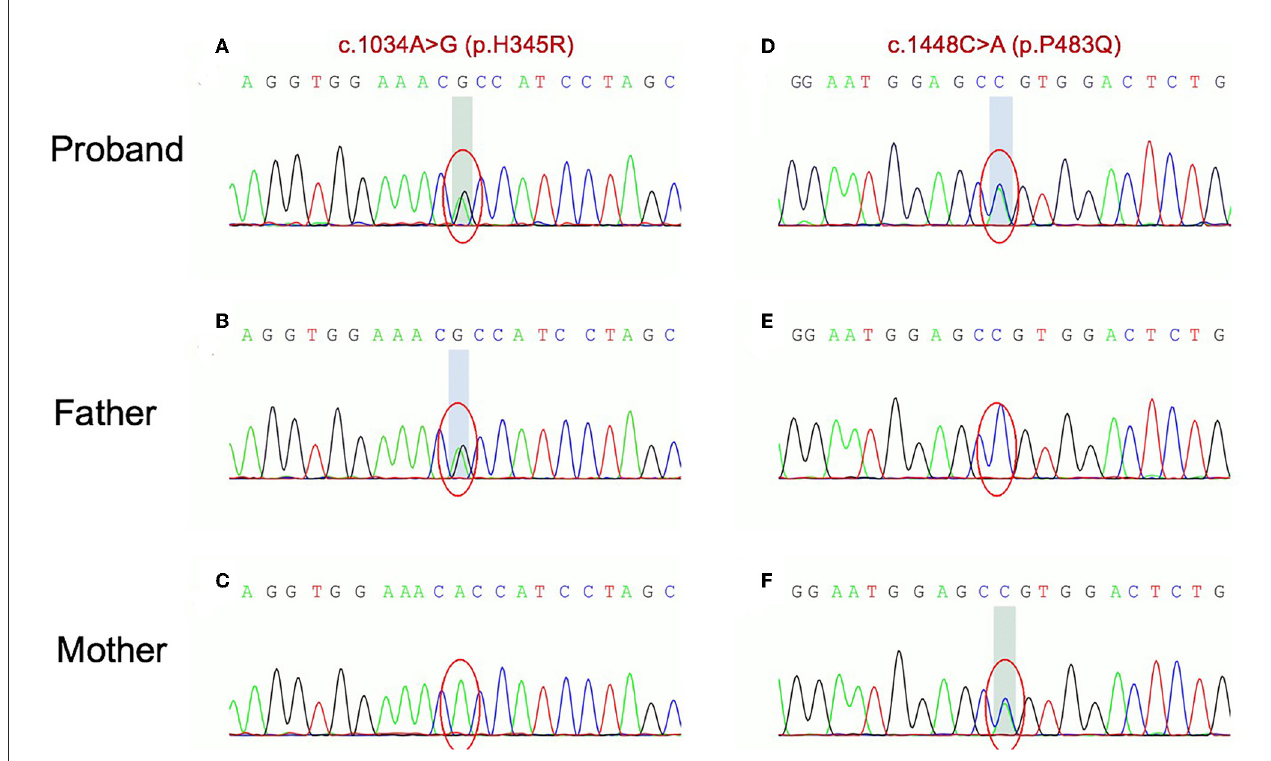
FIGURE3 Sanger traces for PCR products of the proband and his parents. Sanger traces for PCR products of the proband indicated a compound heterozygous mutation in ETFDH gene: c.1034A > G (p.H345R) on exon 9 (A) and c.1448C > A (p.P483Q) on exon 11 (B) . Sanger traces for PCR of his parents. The c.1034A > G (p.H345R) on exon 9 and c.1448C > A (p.P483Q) on exon 11 come from the father and mother (C–F) ,